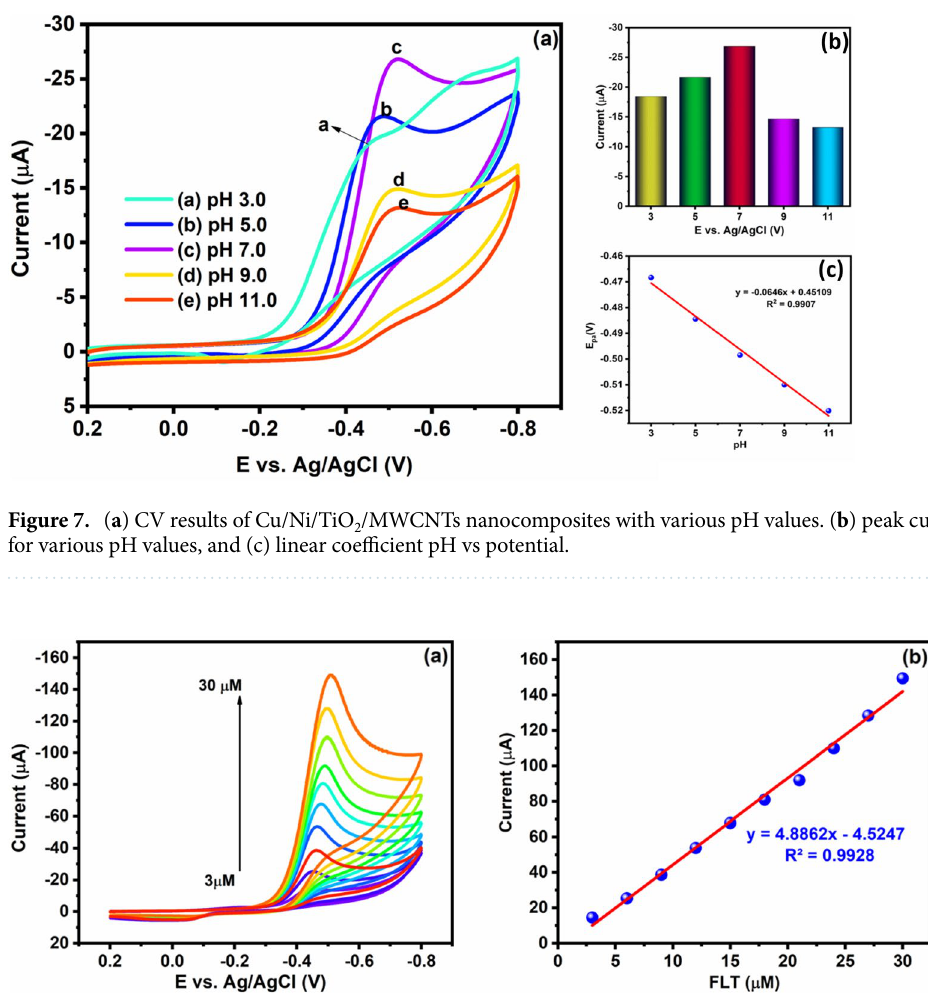
Figure 8. ( a ) Cu/Ni/TiO 2 /MWCNTs nanocomposites with different concentrations of FLT reduction CV curves presence of 0.05 M PBS ( b ) linear regression of peak currents vs different concentrations of